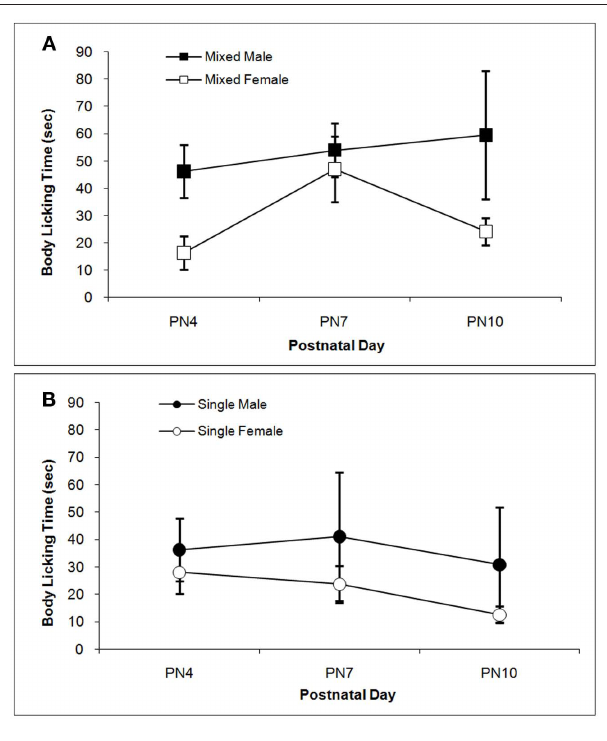
FiguRE 3 | Mean ( ± SEM) times the dam spent licking the anogenital region of her pup are presented for mixed- [squares; (A)] and single- [circles; (B)] sex litters for male (closed symbols) and female (open symbols) rats over postnatal days. Dams lick the anogenital region of male pups more than female pups. See text for statistics.